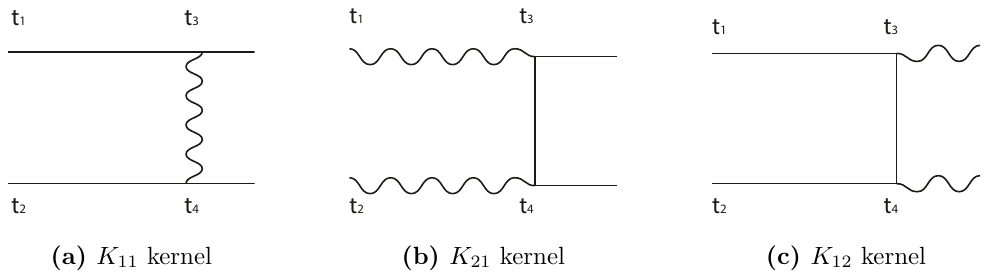
Figure 9. Here we show the relevant kernels for the chaos computation. The subscripts of the kernels denote that they are elements of a matrix. The total matrix acts on a vector consisting of diagrams which starts with either two or two (cid:30)